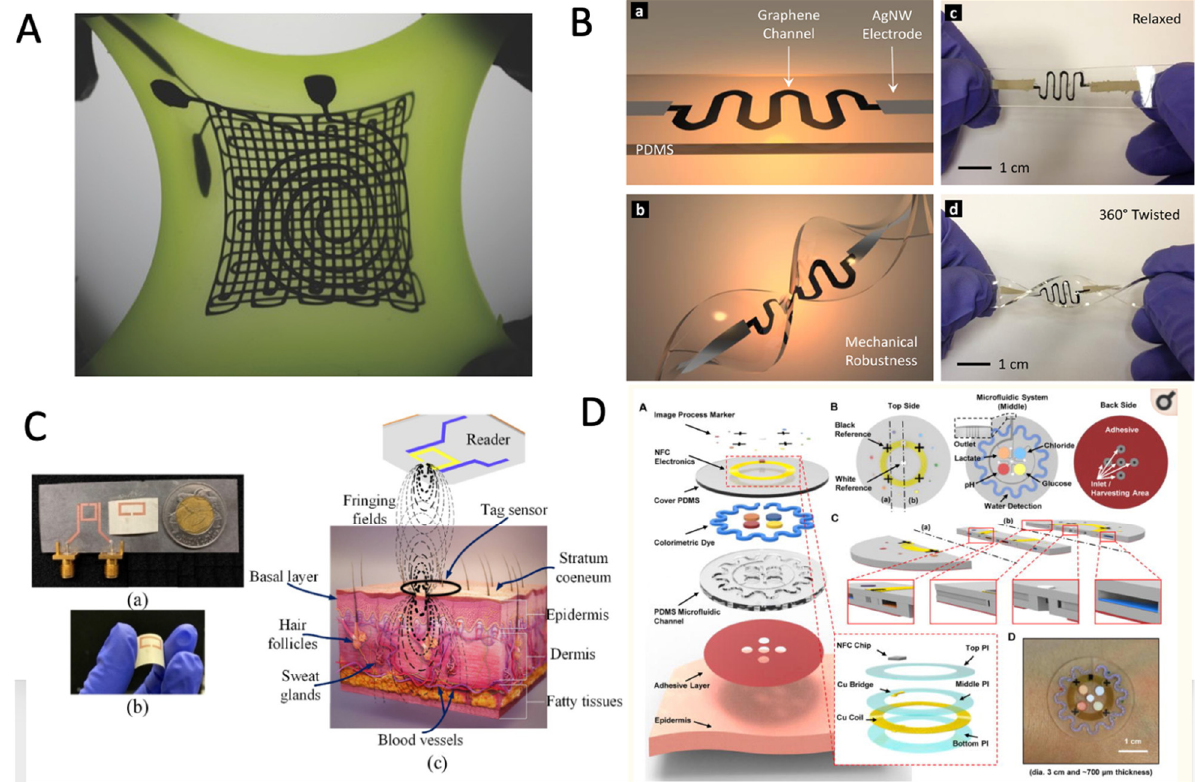
Figure 4. Examples of e-skin sensors: ( A ) Photograph of stretched strain/pressure sensor achieved using e3Dprinting. Reprinted with permission from [204] ( B ) stretchable graphene thermistors (a,b) Schematic diagram and (c,d) representative images of the stretchable graphene thermistors at relaxed and twisted states. Reprinted with permission from [283] ( C ) Operation of a glucose monitoring system: (a) Reader and the tag, (b) Tag flexibility, (c) Detailed illustration depicting the proposed application of this technology. The basal layer contains around 40% of ISF and according to its low distance from the sensor, it is the dominant layer determining the sensor response. Reprinted with permission from [257] ( D ) A wearable device for sweat sensing. Reprinted with permission from [269] .